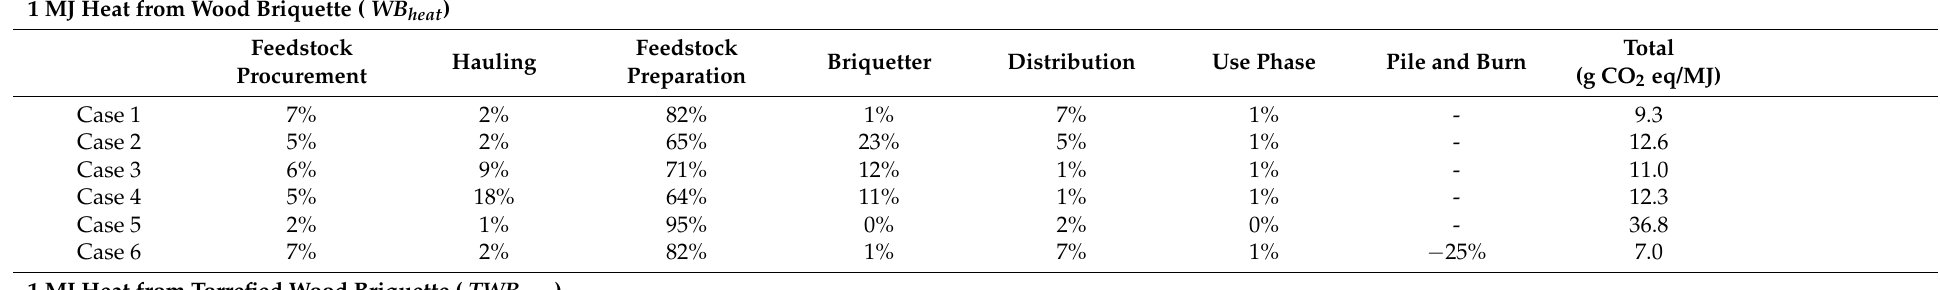
Table 5. Comparison of processes’ contributions to overall global warming impact per 1 MJ of useful heat produced for residential consumers and per 1 kWhe generated at a power plant *. 1 MJ Heat from Wood Briquette ( WB heat